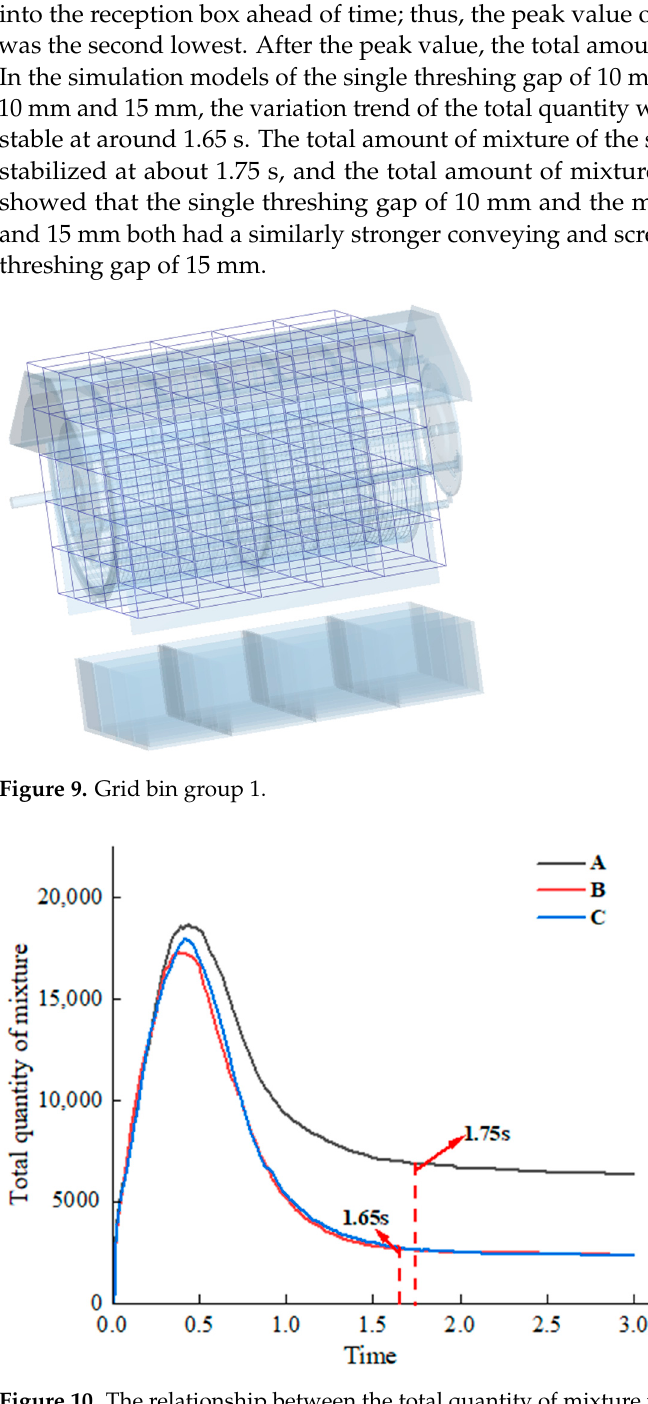
Figure 10. The relationship between the total quantity of mixture in the concentric threshing device and time: (A) single threshing gap of 15 mm; (B) single threshing gap of 10 mm; (C) multi-threshing gaps of 10 mm and 15 mm.